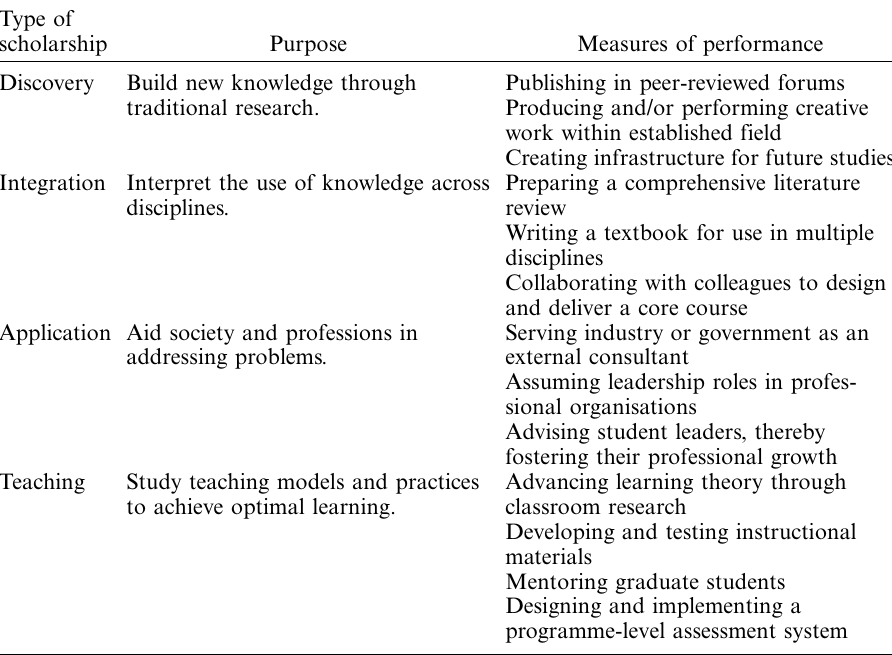
Table 1. Boyer’s Model of